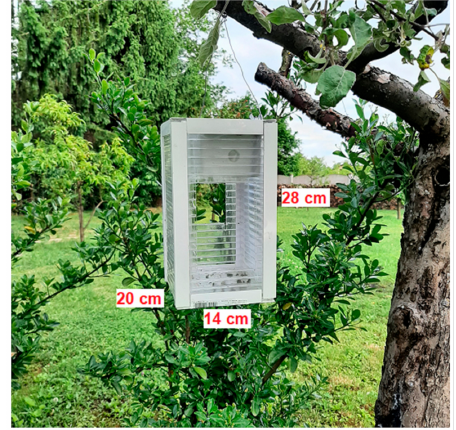
Figure 3. The trap’s